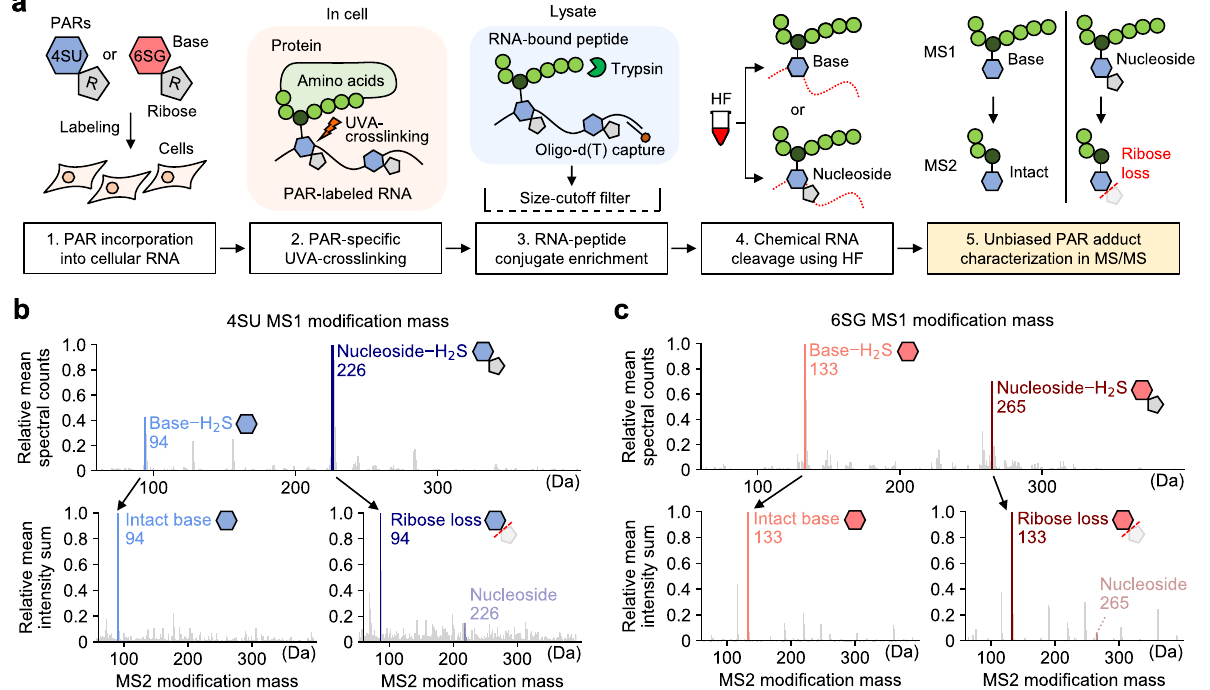
Fig. 1 Characterization of HF-digested PAR adducts. a Experimental scheme for sample preparation for pRBS-ID. Upon photoactivatable ribonucleoside (PAR) labeling, cells are irradiated with UVA to induce protein-RNA crosslinking. The protein-RNA conjugates are enriched using oligo-d(T) 4, 5 , and the protein is digested into tryptic peptides. Then, the peptide-RNA conjugates are enriched by size-cutoff fi ltration, and HF is added to fully digest the RNA into monomers 15 . The resulting PAR adducts are characterized using two open search tools 22, 23 . This information serves as a basis for designing the MS/ MS search pipeline for pRBS-ID. Open search for 4SU-RBS ( b ) or 6SG-RBS ( c ). MS1 modi fi cation mass was measured using MSFragger 22 (top), and the respective MS2 fragment ion modi fi cation on precursor ions with base (bottom left) or nucleoside (bottom right) adducts was analyzed, respectively. Modi fi cation mass ranges of 60 − 400 Da are